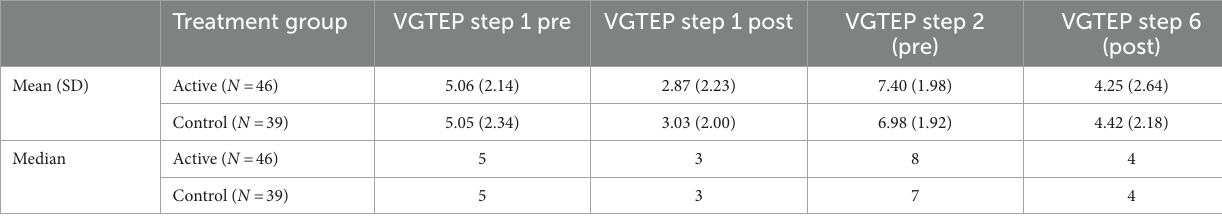
TABLE 4 Descriptive data measuring Subjective unit of disturbance during VGTEP session ( N =